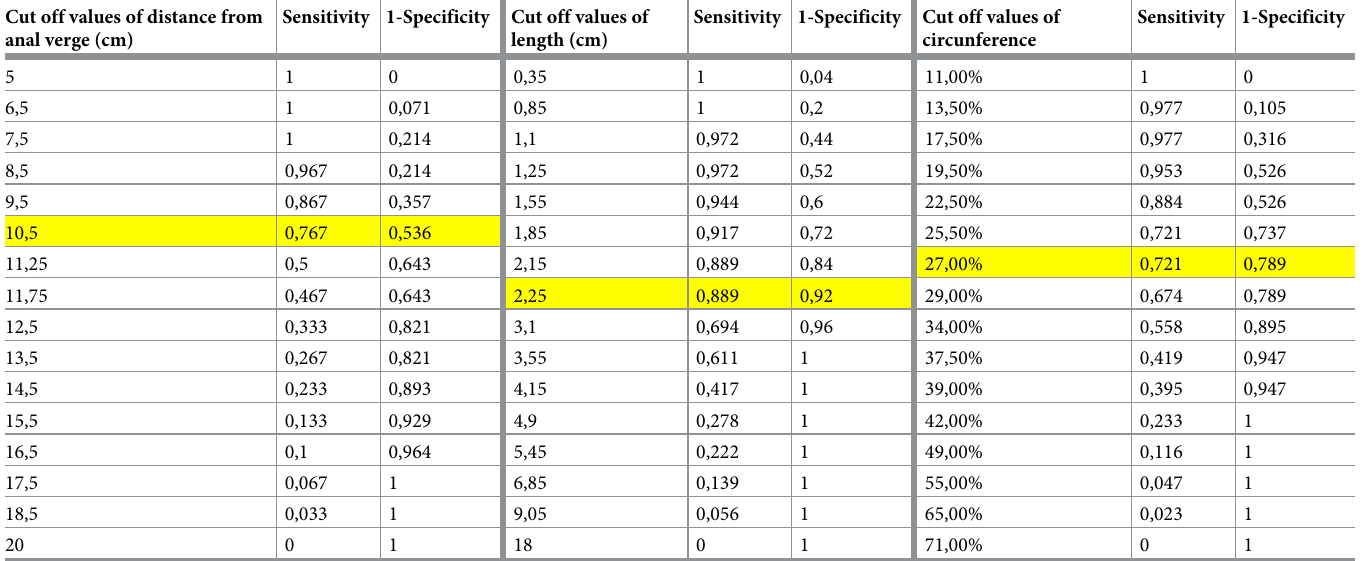
Table 2. ROC curve parameters according to sensitivity and specificity values. Cut off values of distance from Sensitivity 1-Specificity Cut off values of anal verge (cm) length